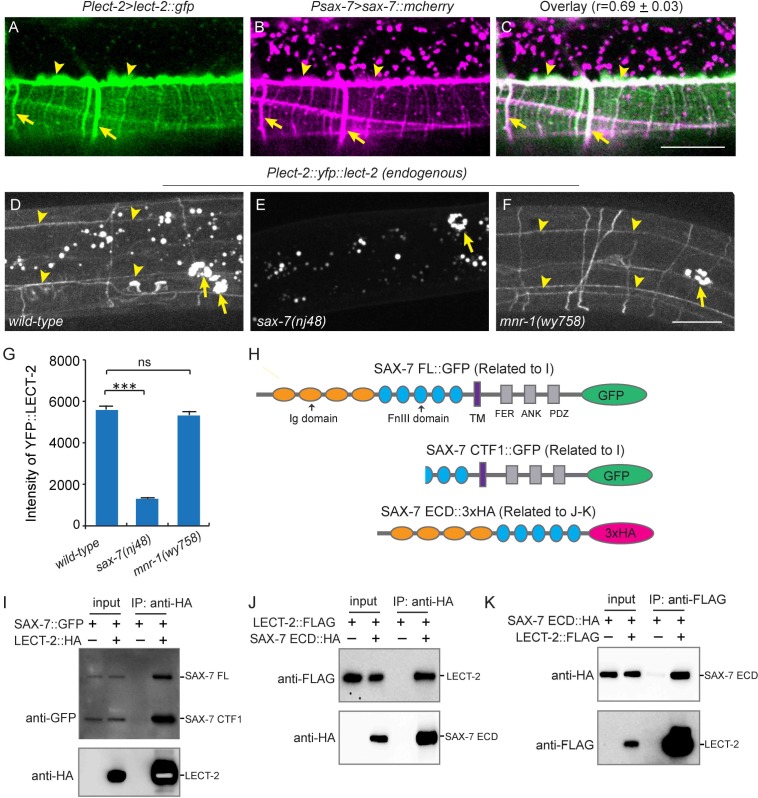
LECT-2 interacts with SAX-7.(A–C) Confocal images showing co-localization between LECT-2::GFP (green) and SAX-7::mCHERRY (magenta). Arrow heads: tertiary line along the border of outer body wall muscles; Arrows: quaternary stripes where quaternary dendrites grow along. Scale bar: 20 μm. The Pearson’s coefficient index was measured from 12 animals. Data are represented as mean ± SEM. (D–F) Confocal images showing the patterns of endogenously expressed YFP::LECT-2 in (D) wild-type, (E) sax-7(nj48) and (F) mnr-1(wy758) mutant animals. Scale bar: 20 μm. (G) Quantifications of intensity of YFP::LECT-2 along the border of outer body wall muscles. Intensity of background was measured in the region outside of worms and subtracted. One way ANOVA with the Dunnett’s test was used for statistical analysis. ***p<0.0001. ns: not significant. Data are represented as mean ± SEM. 10 animals were quantified for each genotype. (H) Schematics of tagged full length or truncated SAX-7 expressed in Drosophila S2 cells for co-immunoprecipitation (co-IP) experiments. FL: full length. Ig: immunoglobulin domain. FnIII: fibronectin domain III. TM: transmembrane domain. FER: conserved FERM domain. ANK: Ankyrin-binding domain. PDZ: PDZ domain. CTF1: C-terminal fragment 1 (generated by cleavage through a putative furin cleavage site in the third FnIII domain). ECD: extracellular domain. (I) Western blot images showing co-IP between LECT-2::HA and SAX-7::GFP. IP: immunoprecipitation. WB: western blot. (J–K) Western blot images showing co-IP between LECT-2::FLAG and SAX-7 ECD::HA. Note that in these experiments a mutant form of SAX-7 ECD::HA construct with furin cleavage site mutations was utilized.